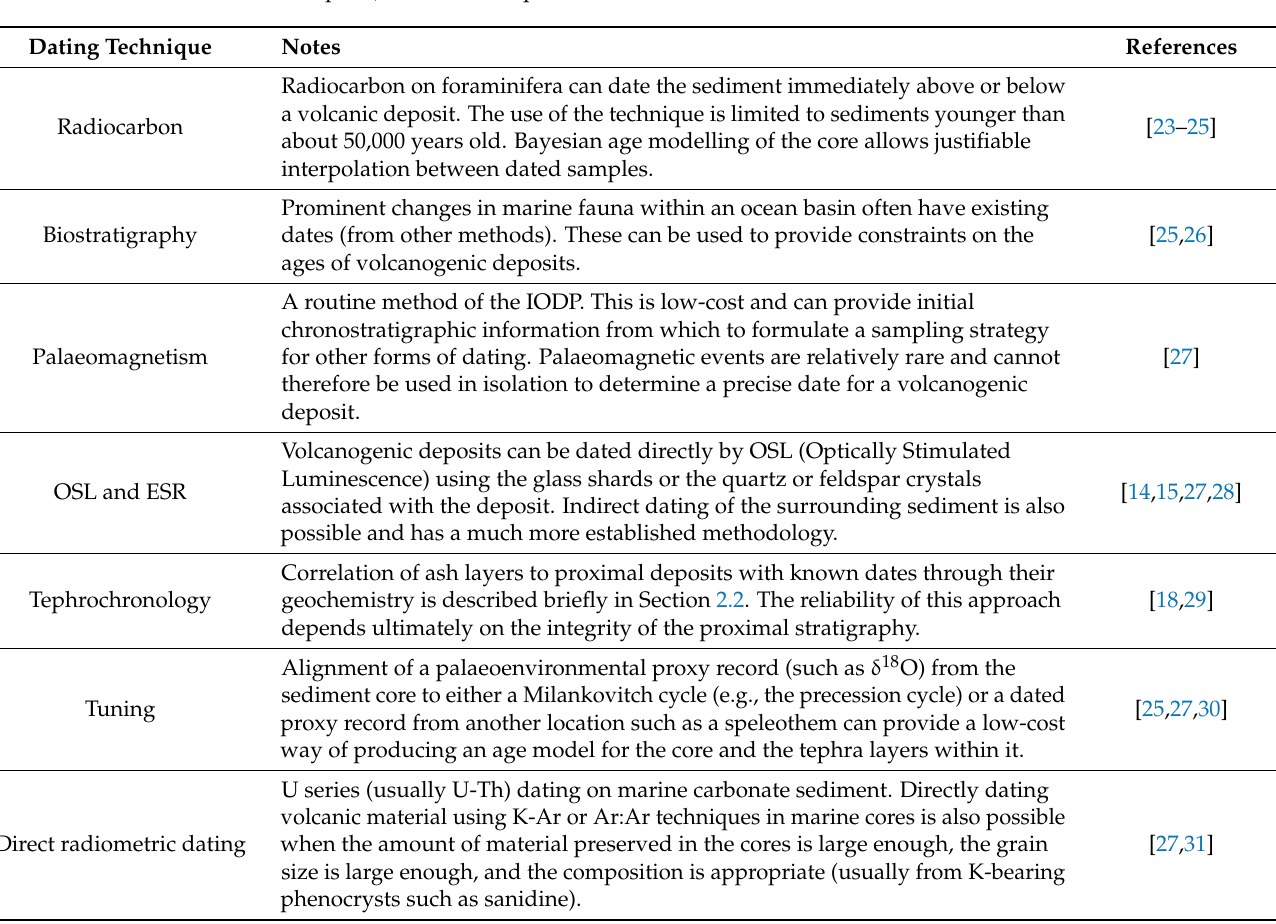
Table 1. Methods of age determination in marine sediment cores. Chronological information from all these techniques can be integrated through a Bayesian age modelling approach [23]. This incorporates both dating and sedimentological information (such as turbidite deposits or erosional surfaces), allowing interpolated dates to be justifiably defined for any depth (such as the depth of a volcanogenic deposit) in the core